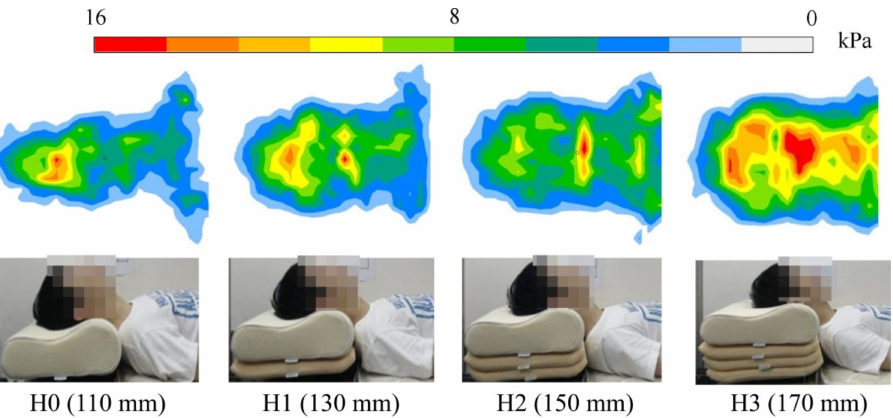
Figure 4. Cranial and cervical pressure distributions of a typical subject under four pillow heights [22] (open